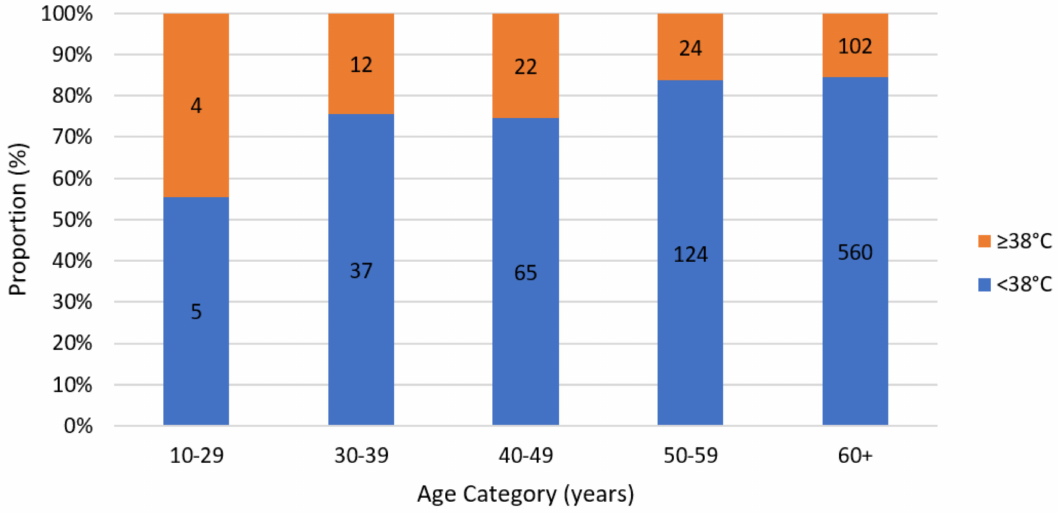
Figure 3. Body temperature by age group in COVID-19 hospitalised patients’ mortality.